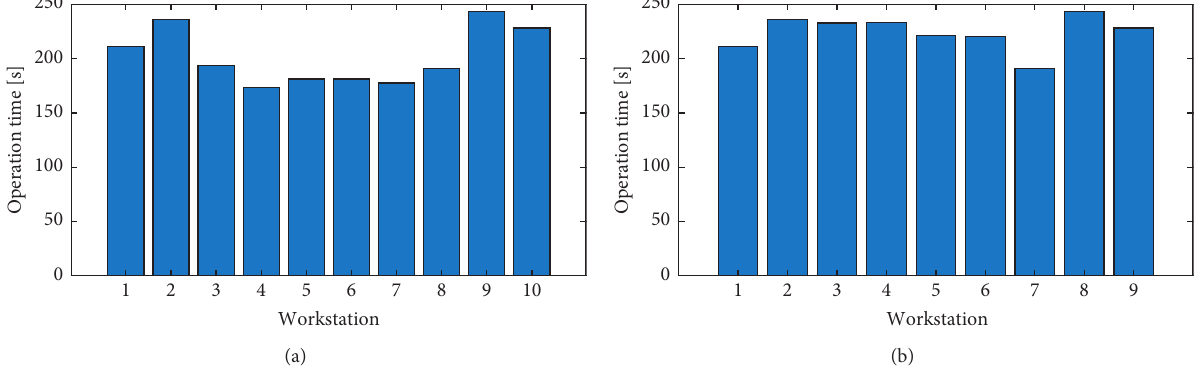
product before and after line balancing. (a) The original case. 1